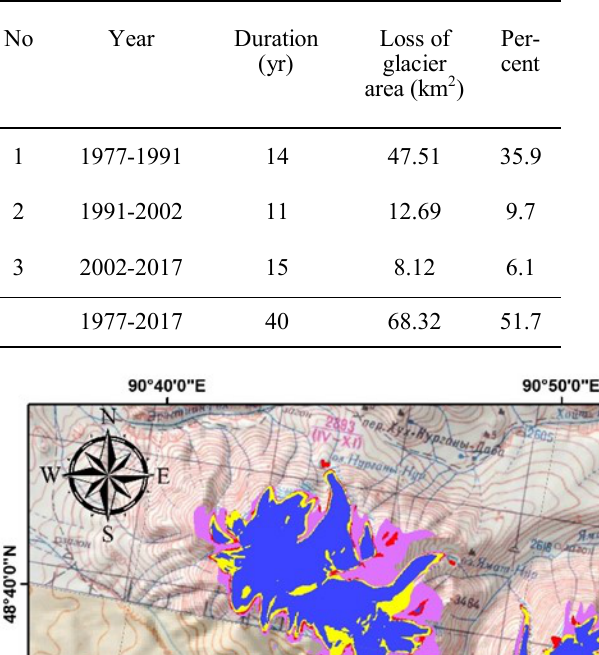
Table 1. Decreased area of the modern glacier in Mt. Tsambagarav.